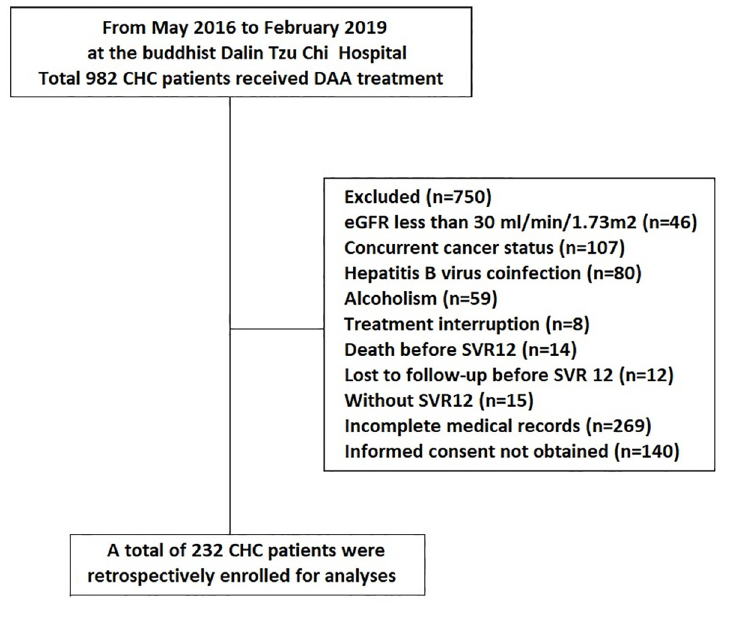
Fig 1. Flowchart of patient